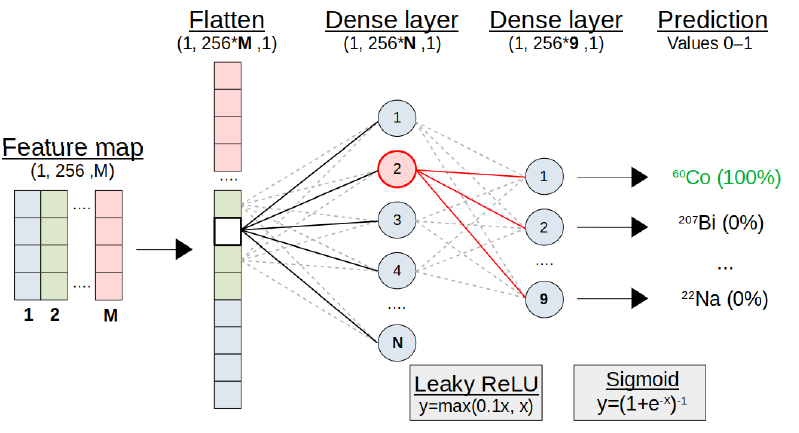
Figure 5. Representation of the classification module. The convolution module output is flattened into a vector. A small ‘fully-connected’ ANN makes final predictions of present sources, with a 0–1 probability through Sigmoid activation. See text for details.